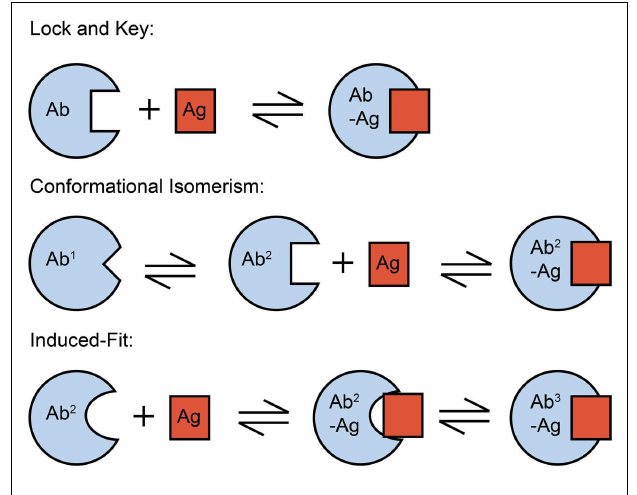
FIGURE 5 | Mechanism of protein-ligand binding reactions. An important distinction between the conformational isomerism and induced-fit mechanisms is the step in the binding mechanism at which the conformational change in the protein occurs – before the initial contact with ligand in the case of conformational isomerism, but afterward in the case of the induced-fit mechanism.The functional impact of this difference is that conformational isomerism can drive polyreactivity by providing alternative protein conformers for the binding of different antigens.